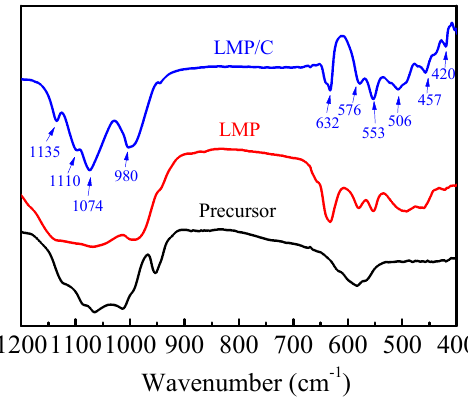
Figure 3. Fourier transform infrared spectroscopy (FTIR) spectra of precursor LMP and